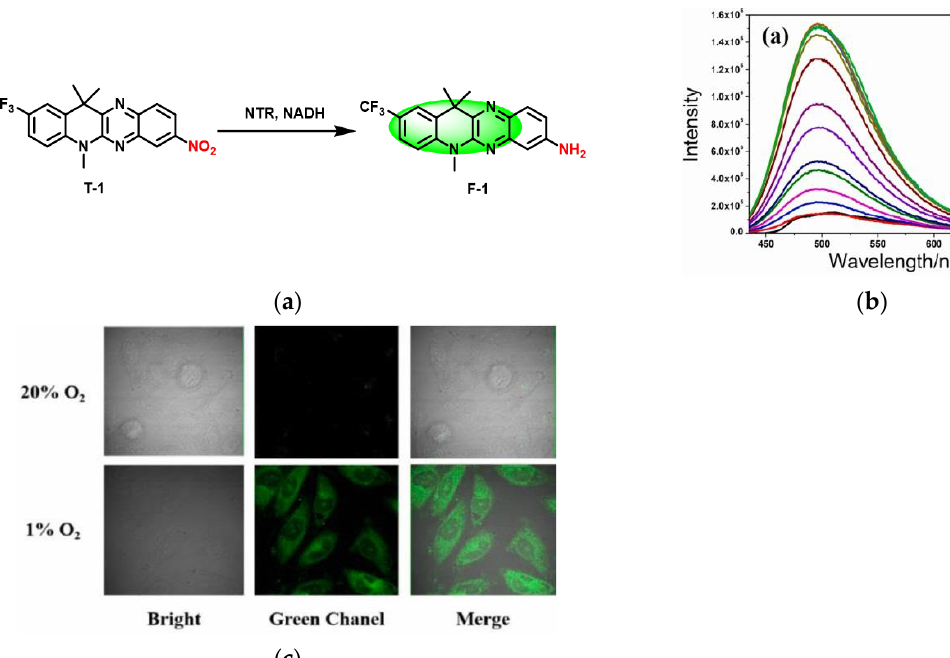
Figure 10. ( a ) Detection mechanism of probe T-1 for NTR; ( b ) Fluorescence spectra changes of